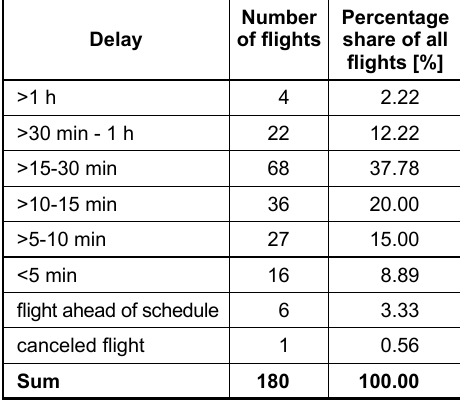
Table 3. Delays on Saturday